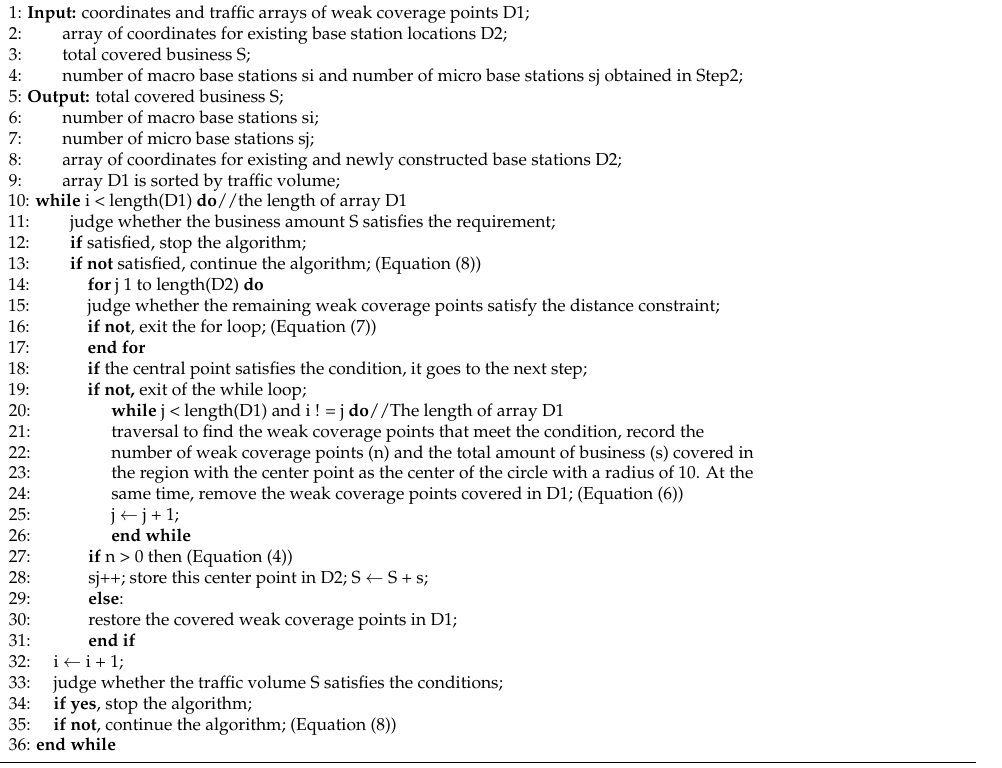
Algorithm 3: Algorithm for determining the number of micro base stations based on traffic sequencing